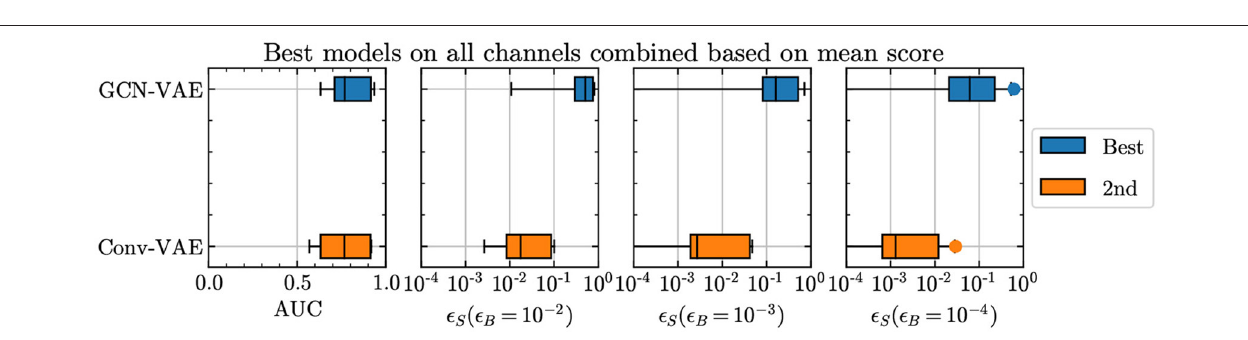
m Eff are extracted and the rest of the layer output is re-shaped and further passed to the subsequent layers of the